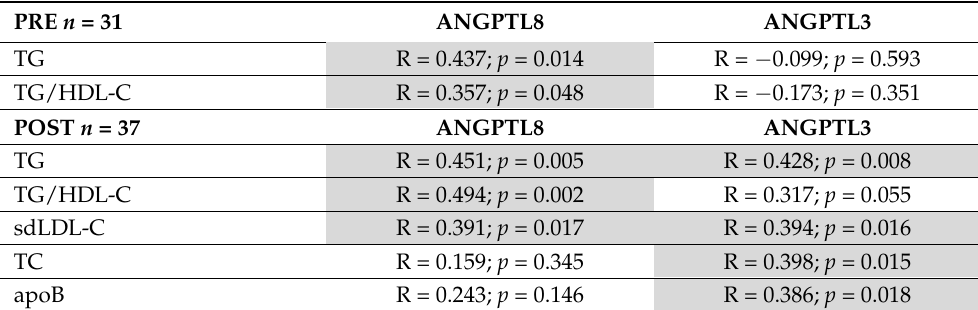
Table 2. Spearman rank correlation coefficients between ANGPTL8 and ANGPTL3, and atherogenic lipid